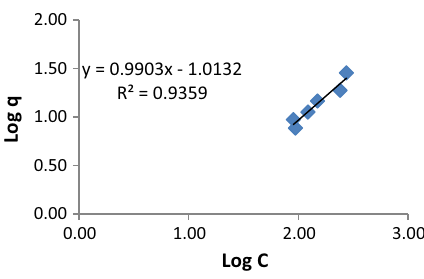
Fig. 8 Freundlich isotherm of spent tea waste y = 10.641x + 0.0016 R² = 0.9153